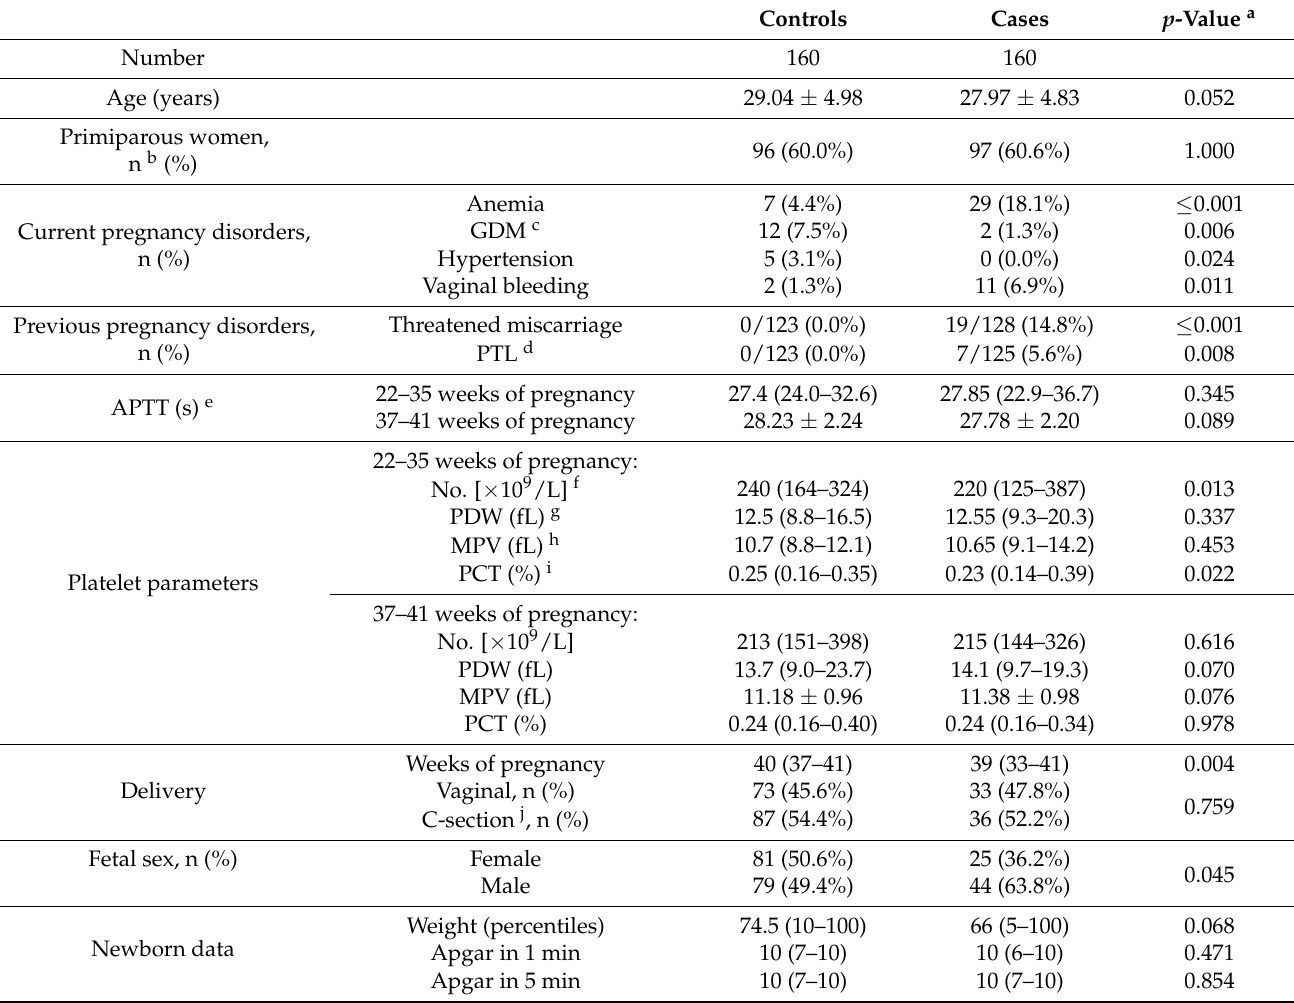
Table 1. Characteristics of the women with spontaneous preterm labor and the controls, included into the